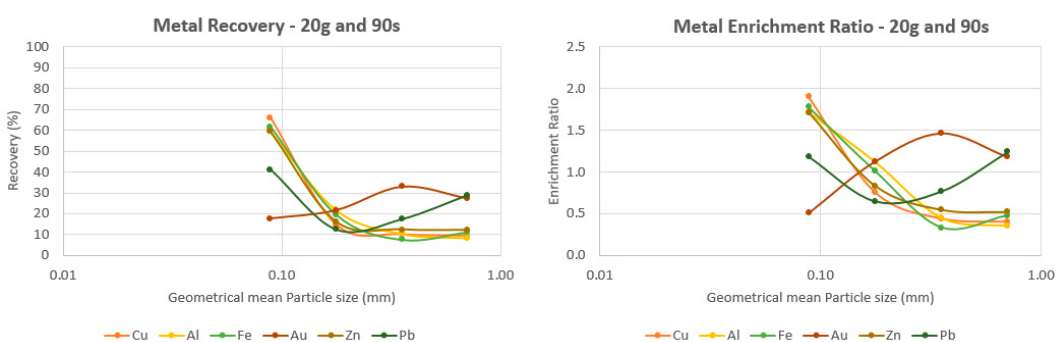
Figure 10. ( a ) Metal recovery and ( b ) Metal enrichment ratio after hammer milling as a function of feed mass, milling time and particle size. Feed particle size fraction was 2–4 mm. The feed mass was 20 g and milling time was 90 s. Experimental data points are connected with lines for the purpose of visual aid only.